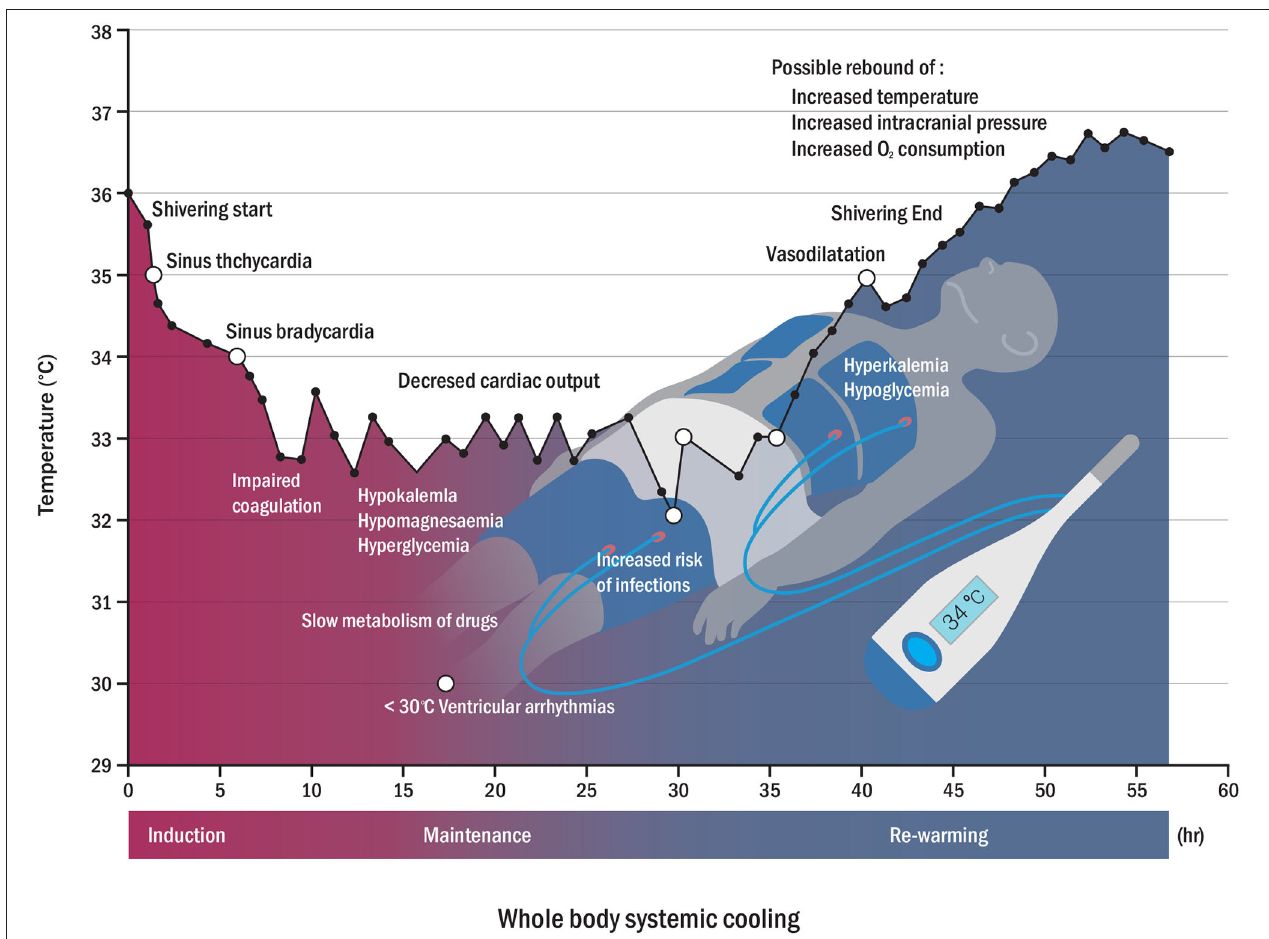
FIGURE 1 | Physiological changes (open circle) and possible side effects (closed circle) according to temperature variation during whole-body cooling. Possible complications may appear in reverse patterns of rewarming complications (hyperkalemia, hypoglycemia, and rebound of increased intracranial pressure, among others) (7,